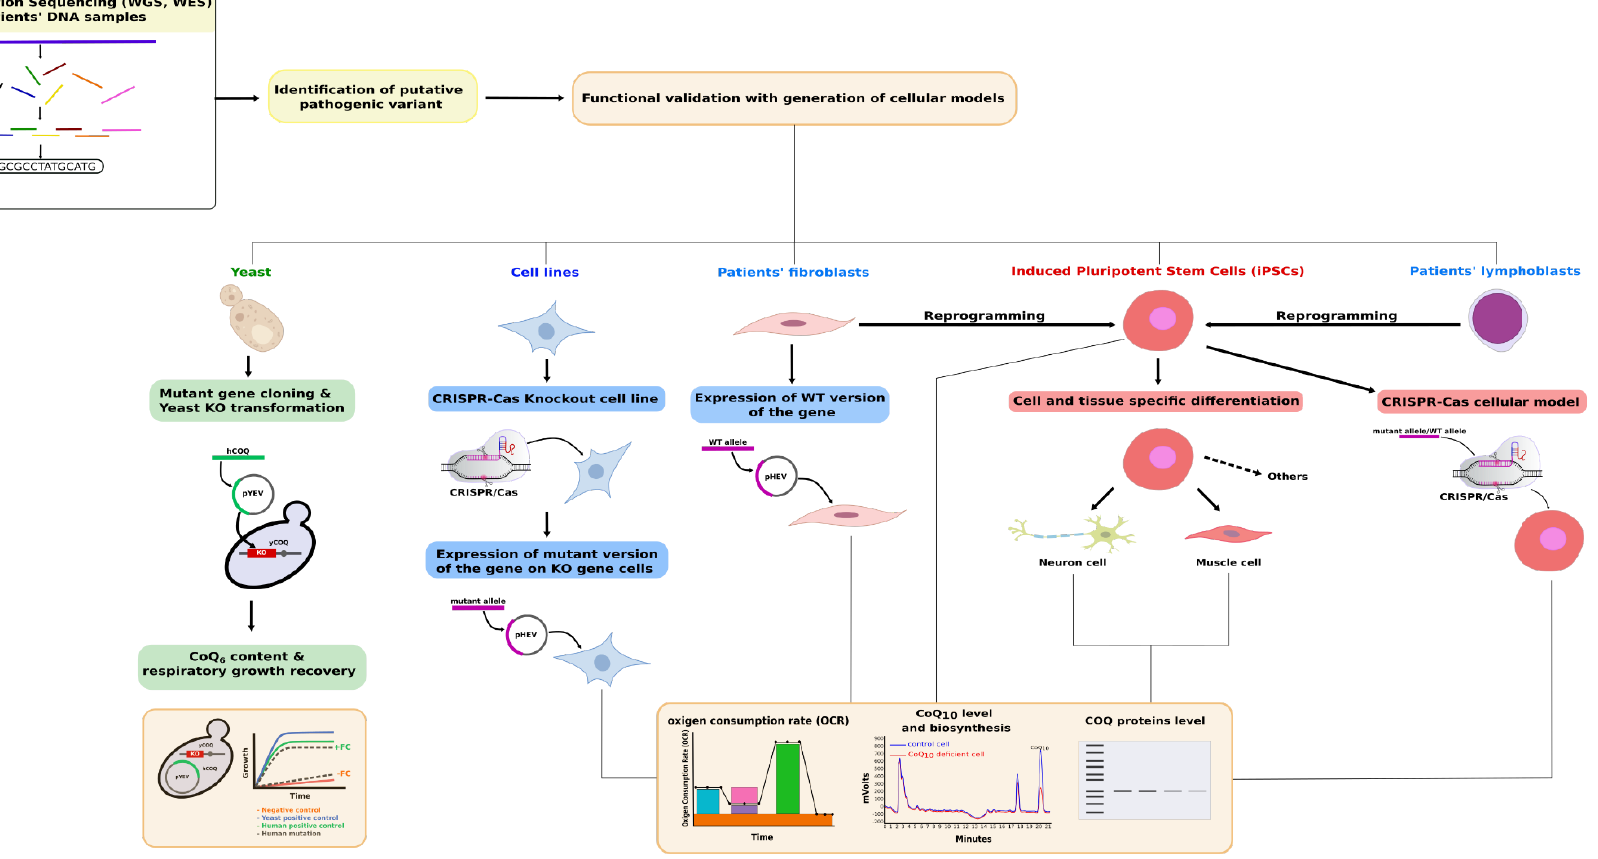
Figure 2. Study of the pathogenesis of human COQ genes variants in cellular models. Variants identified in COQ genes by NGS can be analyzed by functional complementation in yeast, physiologically characterized and validated in the context of skin patient’s-derived fibroblasts, and fibroblasts-derived iPSC to study the implication of defective genes in pluripotent cells physiology and the effect of the variant in tissue-specific differentiated cells.